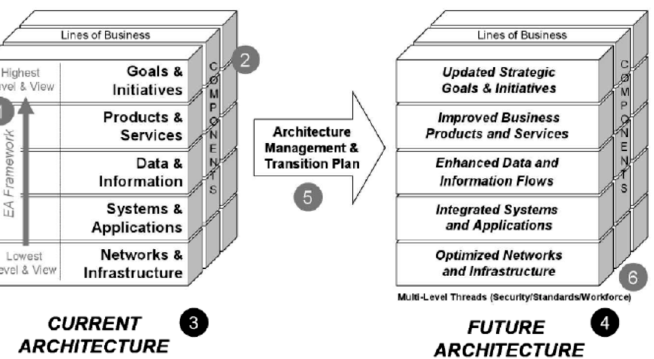
Figure 1. The basic elements of enterprise architecture (EA) analysis and design in EA3 cube framework [11].